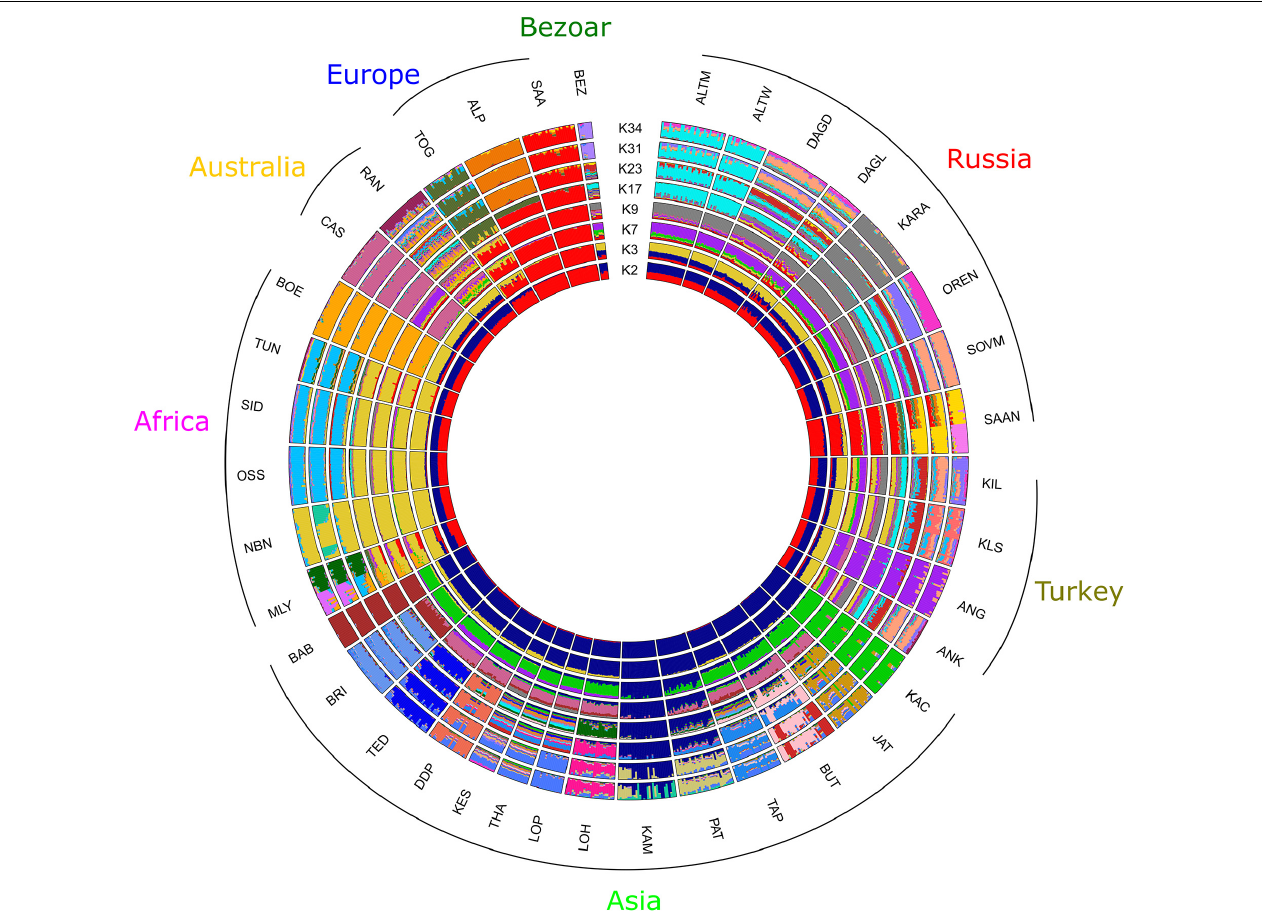
FIGURE 6 | Clustering of Russian goat populations in the context of the dataset of worldwide goat populations from AdaptMap. For a description of the goat breeds, see Table 1